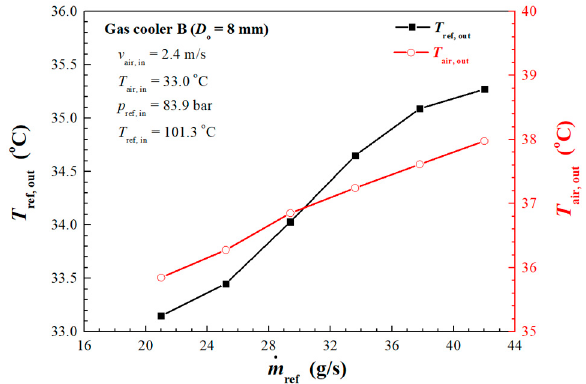
Figure 10. Influence of refrigerant mass flow rate on heat-transfer rate and sCO 2 pumping power for gas cooler A.